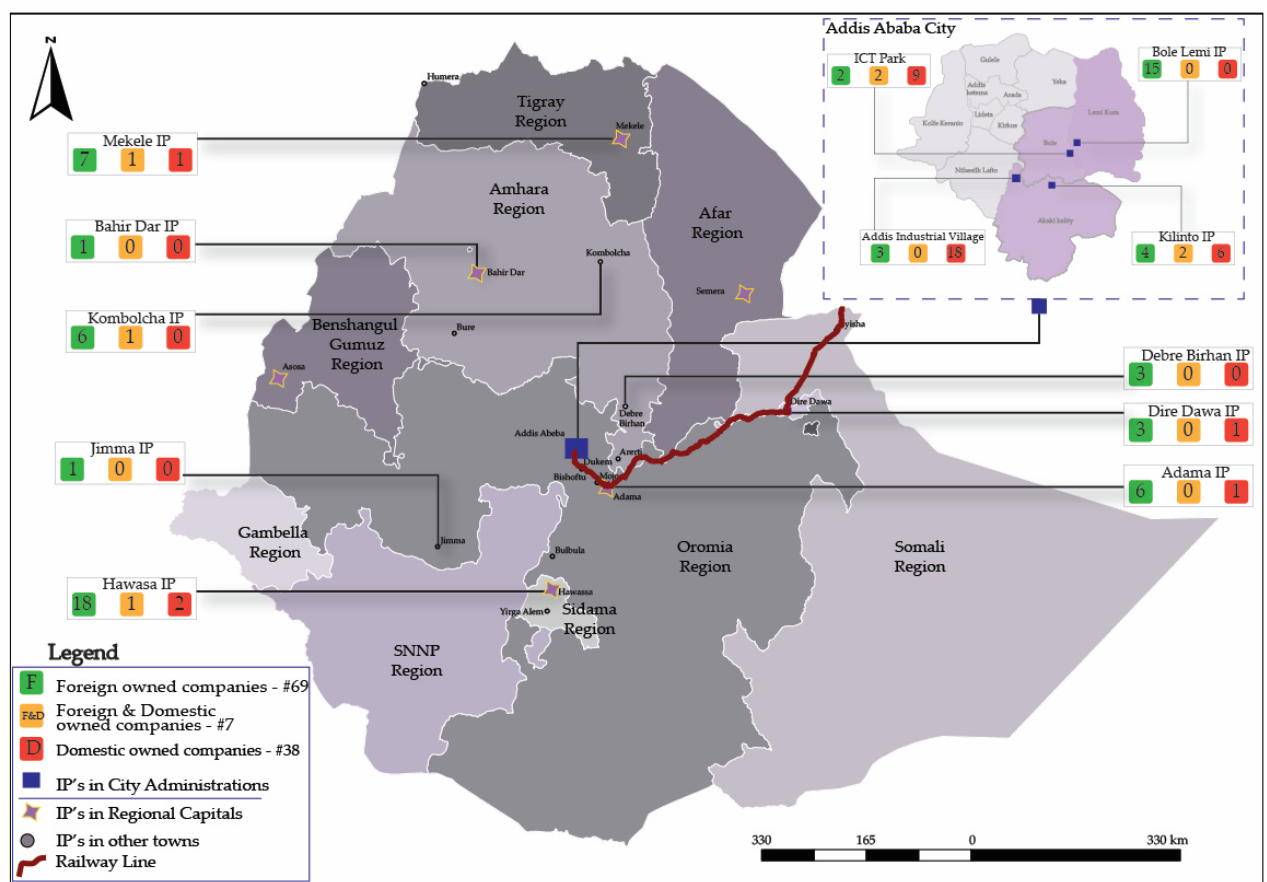
Figure 4. Distribution of federal-owned IPs; source: [48], Prepared by the authors.